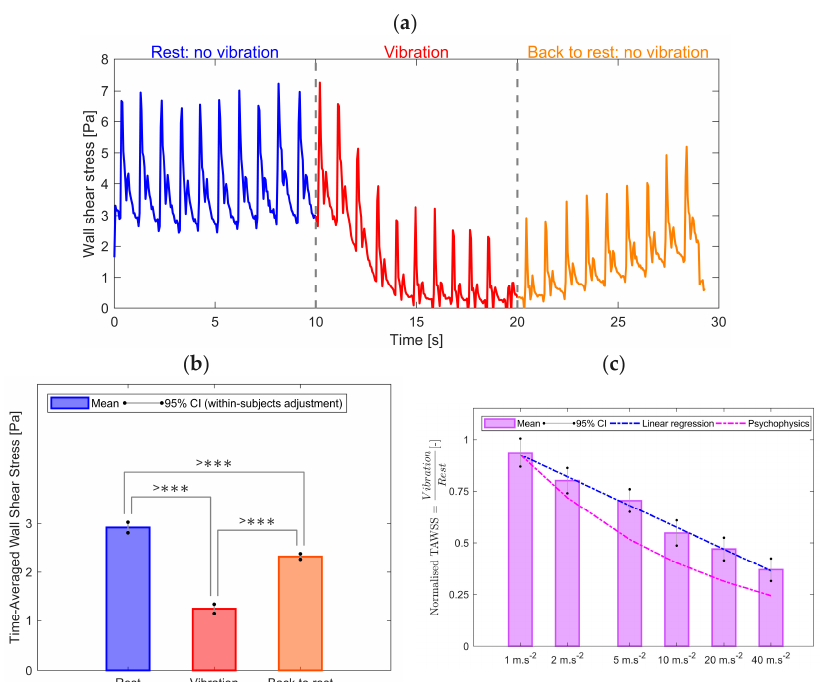
Figure 12. ( a ) Example of reduction in WSS caused by vibrations on a volunteer; ( b ) statistical synthesis of the influence of vibration (>*** means p -value < 0.0001); ( c ) statistical synthesis of the influence of the amplitude of vibration.